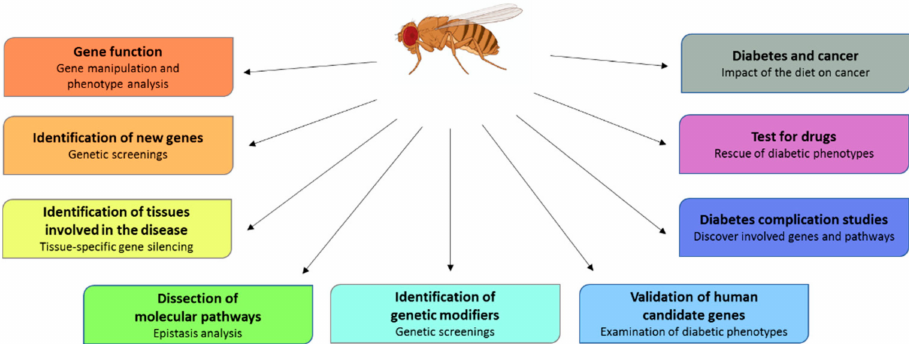
Figure 5. Advantages and applications of Drosophila as a diabetes model. Drosophila offers the possibility of studying diabetes by employing numerous approaches to increase DM knowledge and provide translational